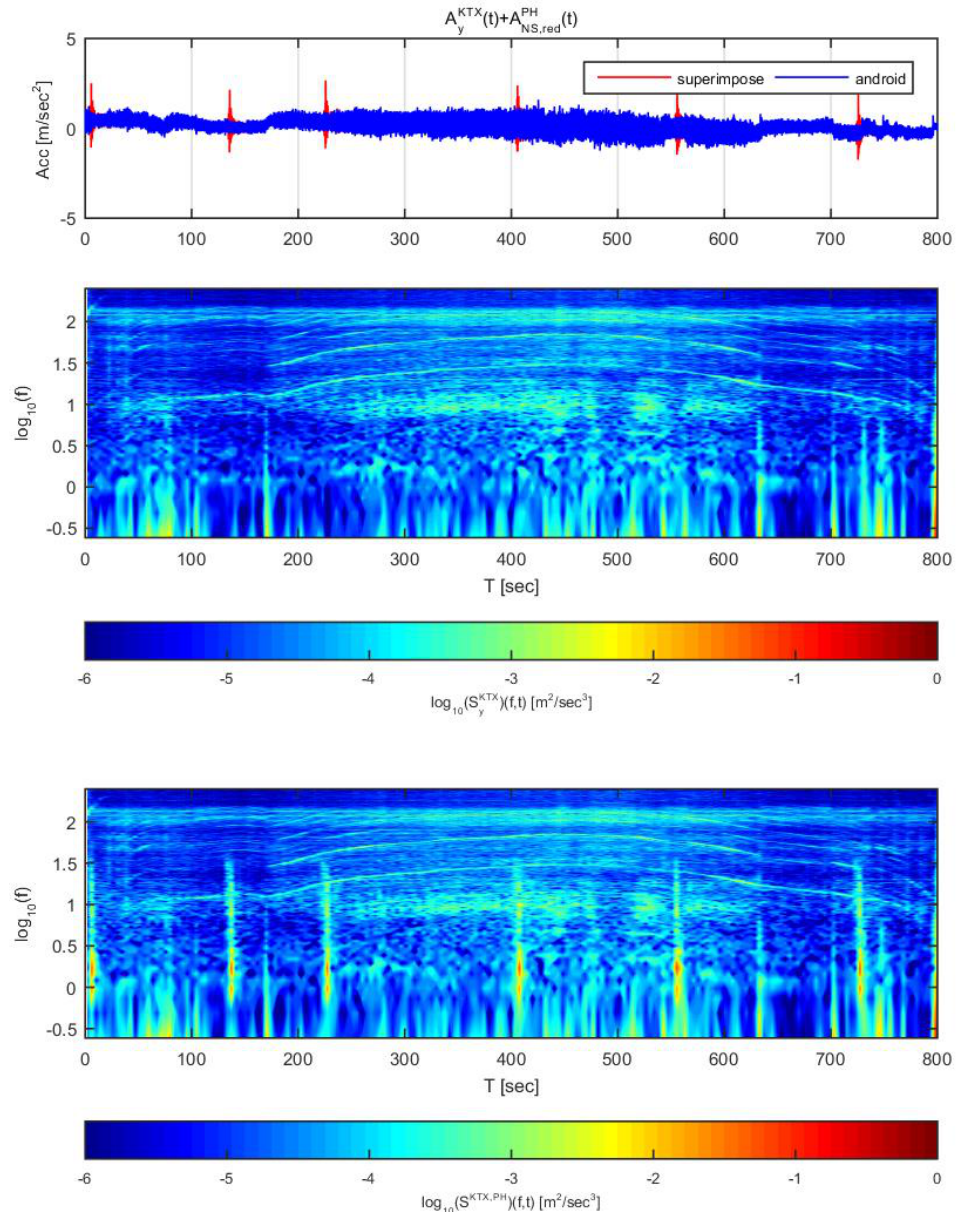
Figure 17. Combination of Korea Train Express (KTX) x-direction data and Pohang earthquake north-south direction data (adjusted to 1 m / s 2 ).